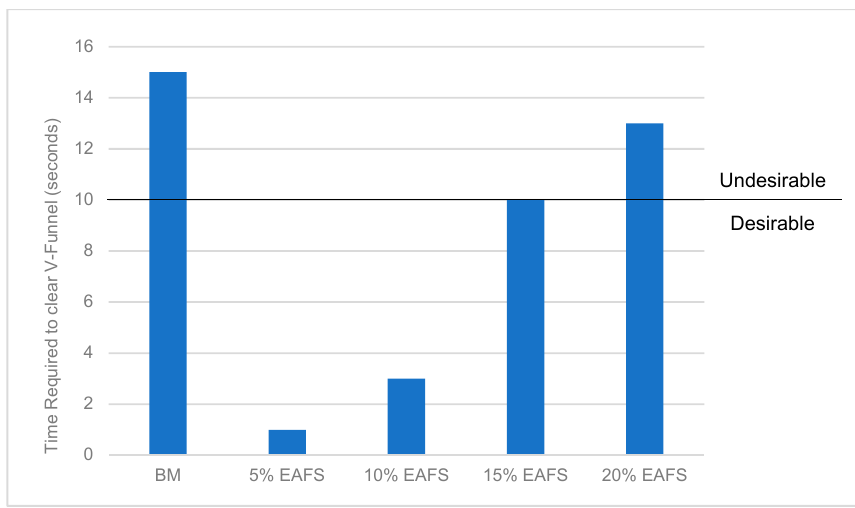
Figure 13. The time taken for SCC samples containing varying doses of EAFS to pass through a V-Funnel.